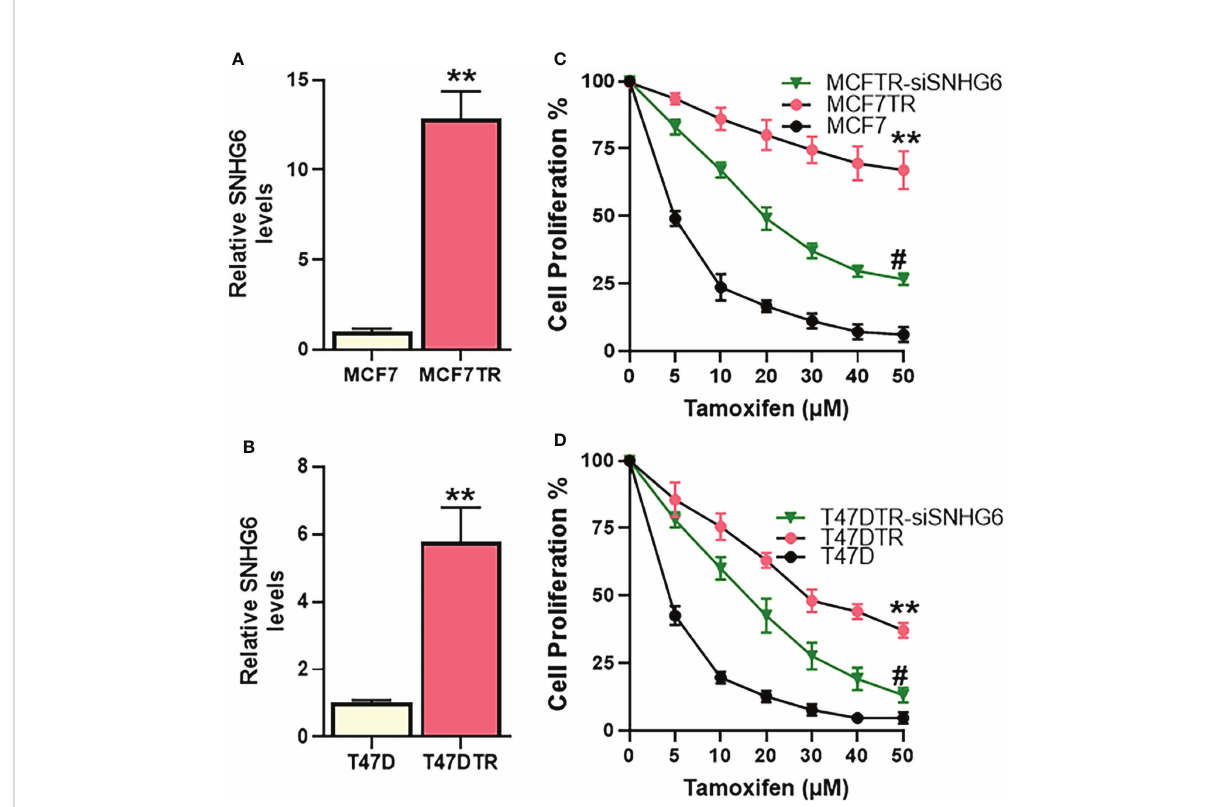
FIGURE 1 SNHG6 expression and function in tamoxifen resistant ER-positive Breast cancer cells. Expression of SNHG6 was quantitated in tamoxifen- resistant (A) MCF-7 cells (MCF7TR) and (B) T47D cells (T47DTR) by qRT-PCR. The levels of SNHG6 in parental cells (MCF-7/T47D) were assigned a value of 1 and the relative levels in tamoxifen-resistant derivatives are plotted. Cell proliferation was measured by MTT assay in paired cell lines (C) MCF-7/MCF7TR and (D) T47D/T47DTR after the cells were exposed to indicated concentrations of tamoxifen for 48 hours. Further, tamoxifen resistant MCF7TR and T47DTR were subjected to SNHG6 silencing and then treated with increasing concentrations of tamoxifen for 48 hours before the proliferation was assessed using MTT assay. **p<0.01, compared to native controls and #p<0.01, compared to respective resistant cells without SNHG6 silencing.